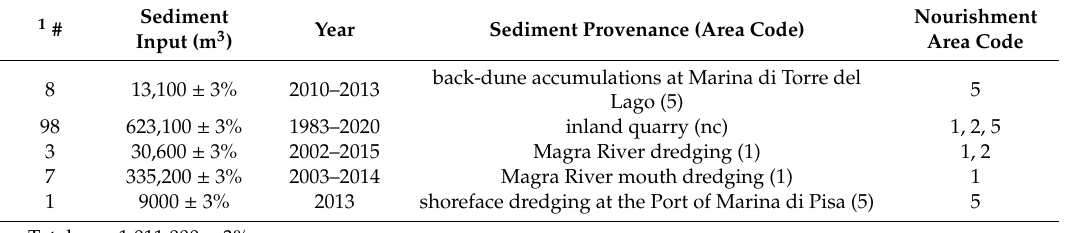
Table 1. Volume of sediments used as nourishments in the 1980–2020 timespan along the considered sector of coast, sorted by the provenance of material used as beach fill. Refer to Table S1 for a detailed list of each nourishment